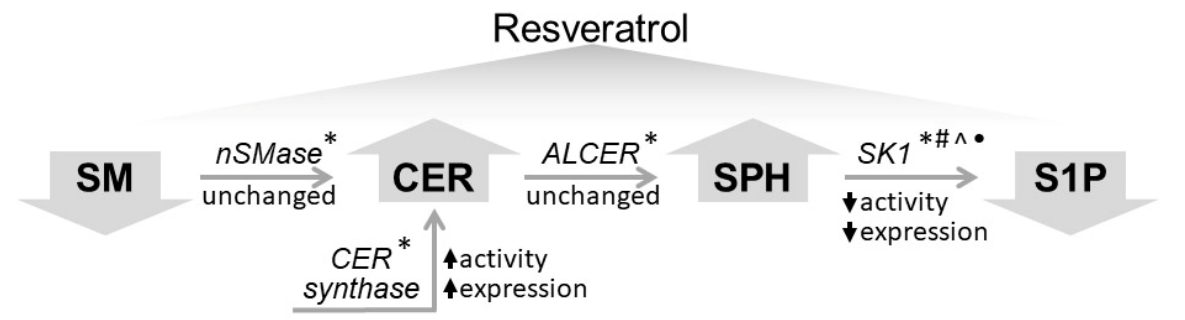
Figure 9. Schematic presentation of the effects of resveratrol on sphingolipid metabolism in lung cancer A549 cells. SM—sphingomyelin; CER—ceramide; SPH—sphingosine; S1P—sphingosine-1-